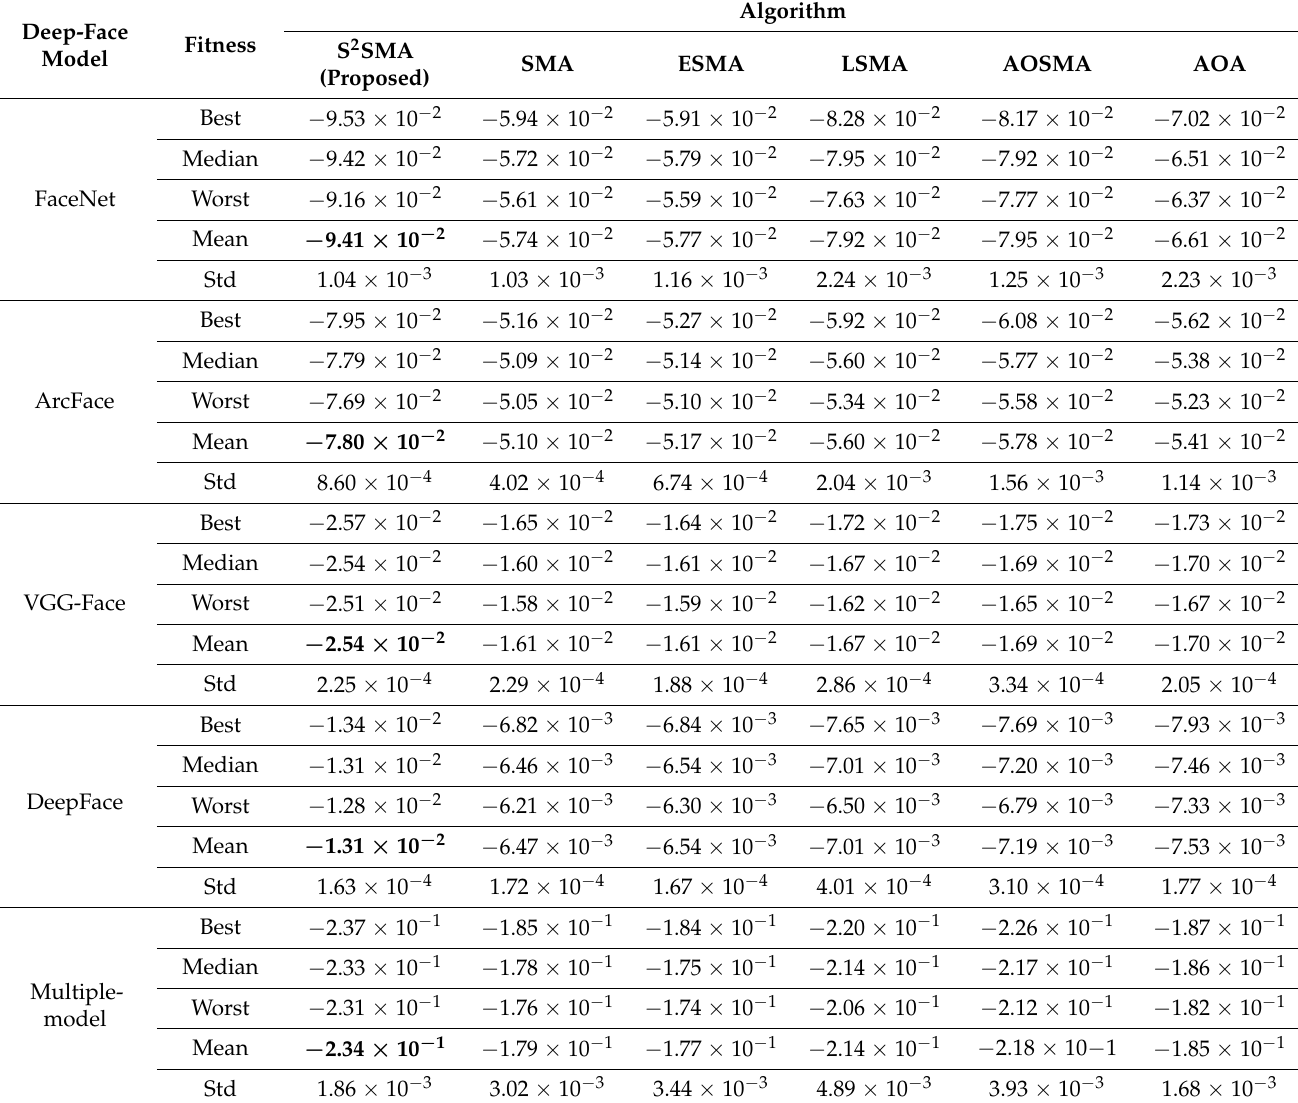
Table 10. The fitness outcomes of several single-model and multiple-model approaches on